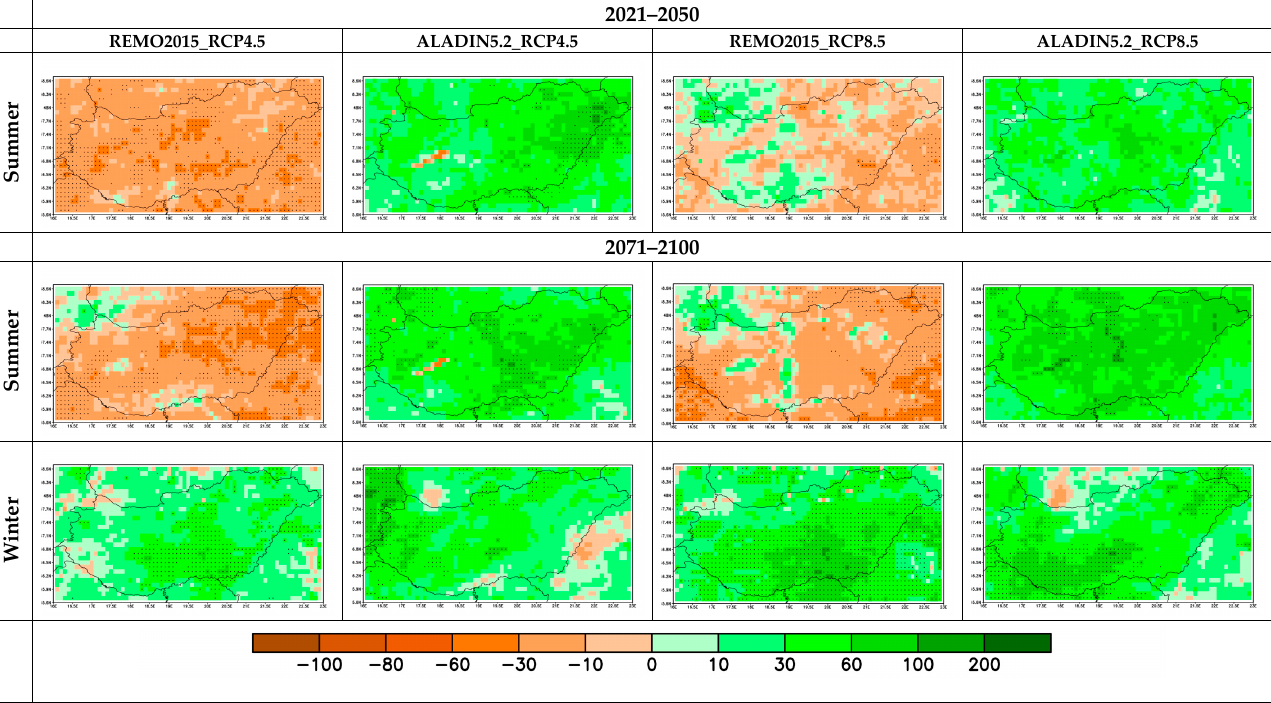
Figure 21. Relative change in the number of heavy precipitation days (%) in summer for 2021–2050 and 2071–2100, and in winter for 2071–2100 in Hungary based on the ALADIN5.2 and REMO2015 simulations. Reference period: 1971–2000.